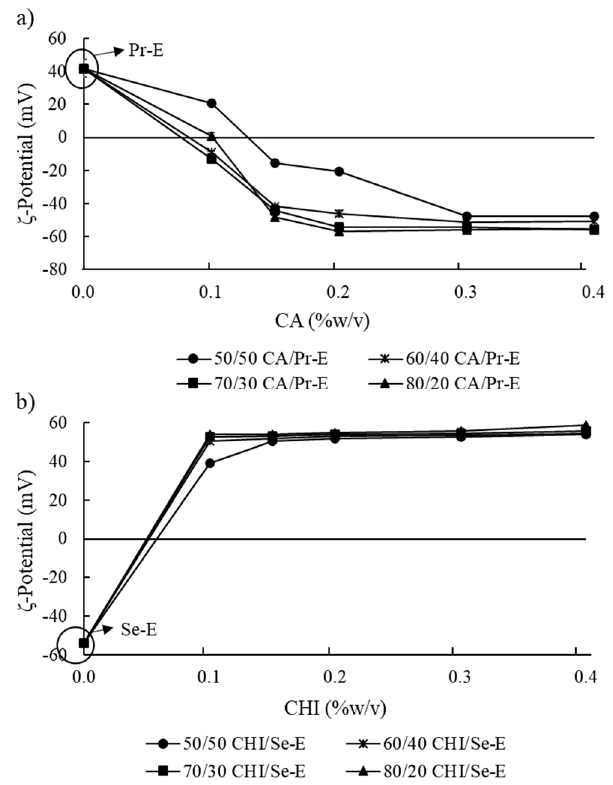
Figure 3. Effect of ( a ) ι -carrageenan (CA)/ Primary emulsion (Pr-E) and ( b ) chitosan (CHI)/second- ary emulsion (Se-E) in different ratios (50/50 to 80/20% w/w ) on the ζ -potential.